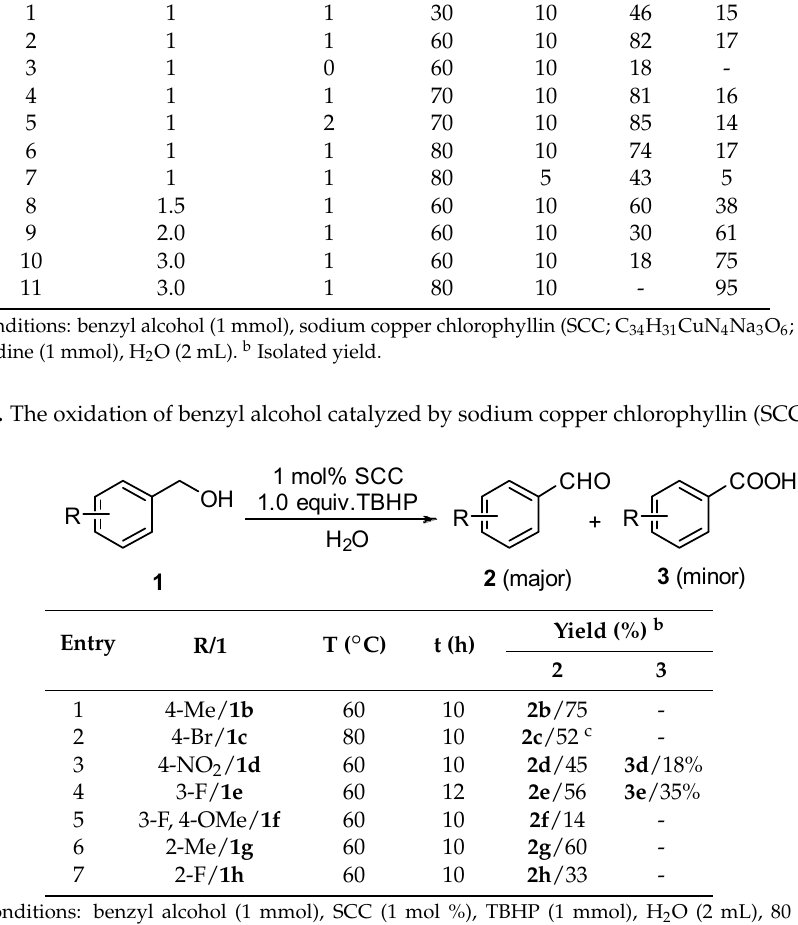
Table 3. The oxidation of benzyl alcohol catalyzed by SCC a .